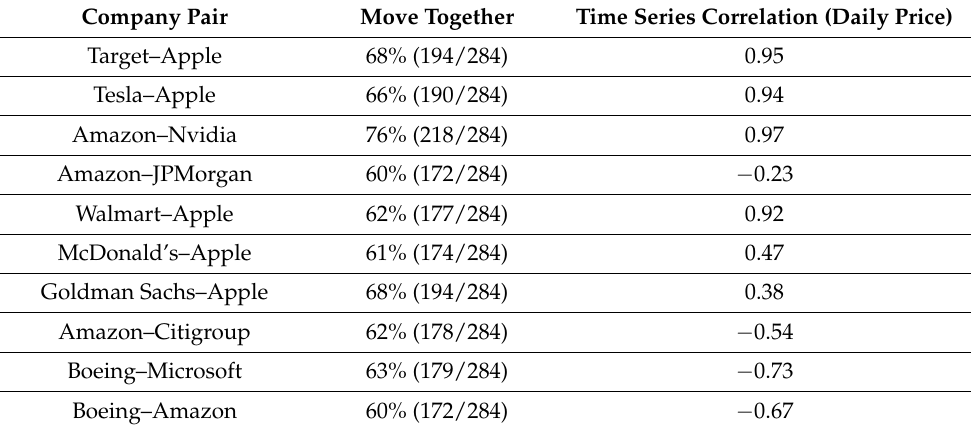
Table 6. Notable pairs moving together compared to price only